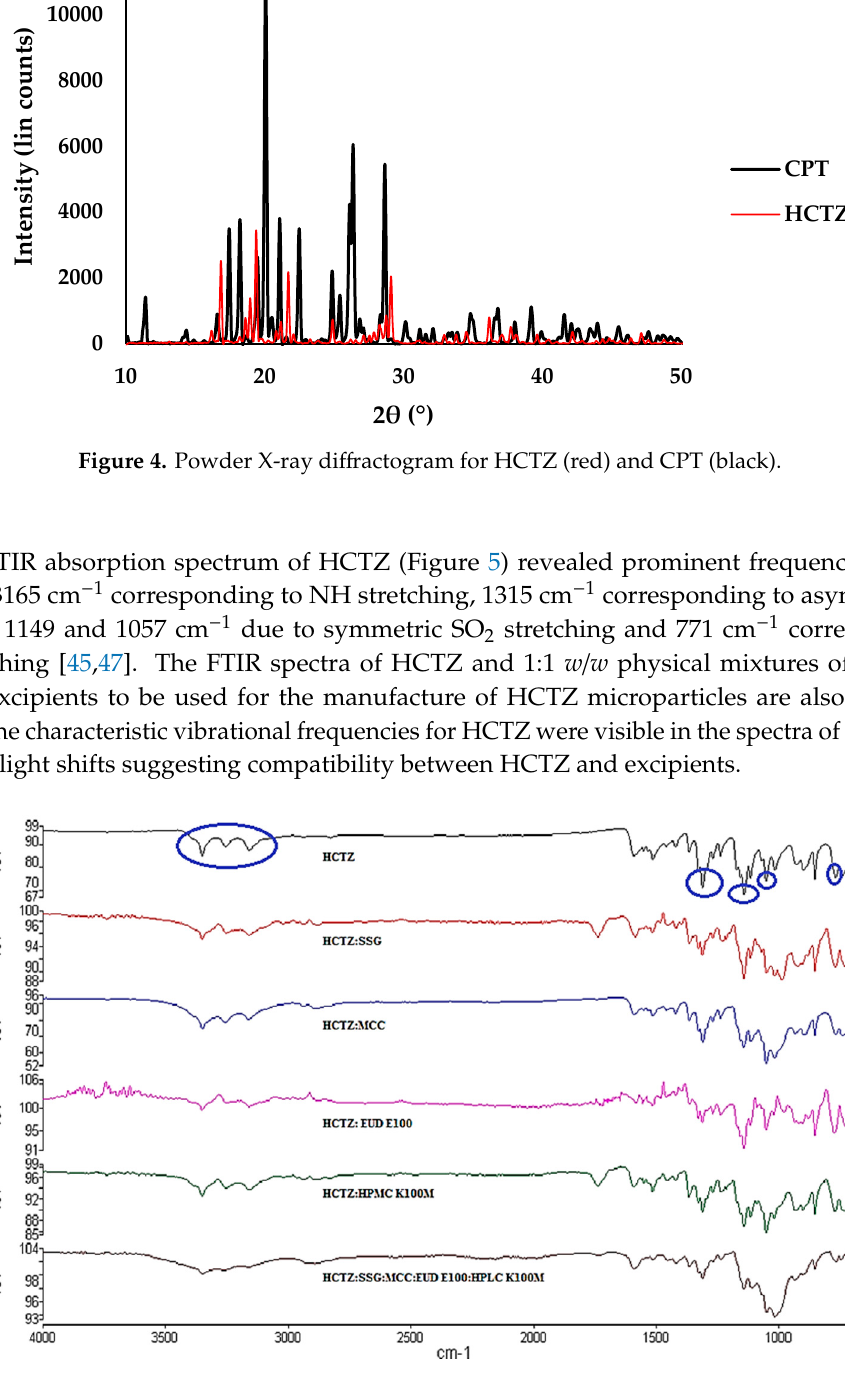
Figure 5. Fourier transform infrared spectroscopy (FTIR) absorption spectra of HCTZ and 1:1 mixtures of HCTZ and excipients.